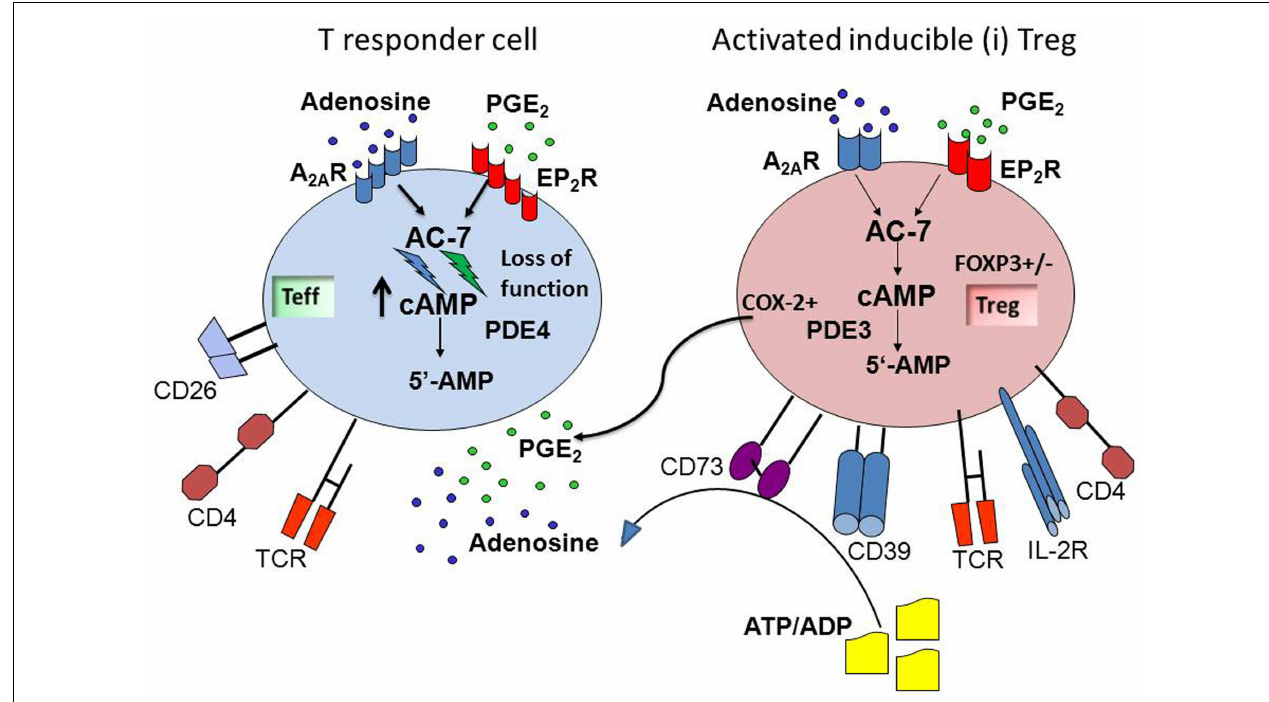
adenylate cyclase-7 (AC-7) and lead to an increase in intracellular levels and activation of 3 (cid:48) ,5 (cid:48) -cAMP.This results in suppression of cellular functions in responderT cells.The cooperation between ADO and PGE 2 is mediated at the level of the AC-7, which together with cellular phosphodiesterase (PDE4) is responsible for regulating 3 (cid:48) ,5 (cid:48) -cAMP levels in cells.The ADO and PGE 2 -mediated cooperative inhibition ofT effector functions via up-regulation of 3 (cid:48) ,5 (cid:48) -cAMP levels represents one of the mechanisms utilized by iTreg for inducing immune